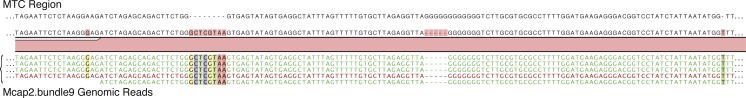
Mapping of Mcap2.bundle9 genomic data to the MTC region (716 bp).Nine high quality SNPs/indels were found, varying in frequency from 4.9% to 18% in the MTC region. Of these SNPs/indels, 6% of the reads in one region encoded an 8 nt insertion that co-segregated (i.e., in the same reads) with a 5 nt deletion from a G-rich region, a downstream single nucleotide insertion, and one upstream SNP.